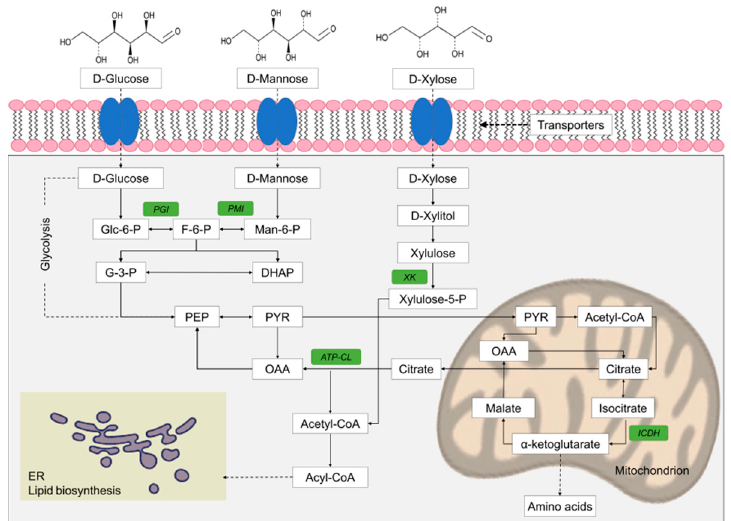
Figure 2. Simplified scheme of glucose, mannose, and xylose catabolism and principal enzymes involved in lipid biosynthesis. The key-enzymes considered in this study are highlighted in green. ICDH, NAD + -dependent isocitrate dehydrogenase; PGI, phosphoglucose isomerase; PMI, phosphomannose isomerase; XK, xylulokinase; ATP:CL, ATP citrate lyase (from Valdés et al. [119], Reproduced with permission from Applied Biochemistry and Biotechnology, Springer Nature, 2020).